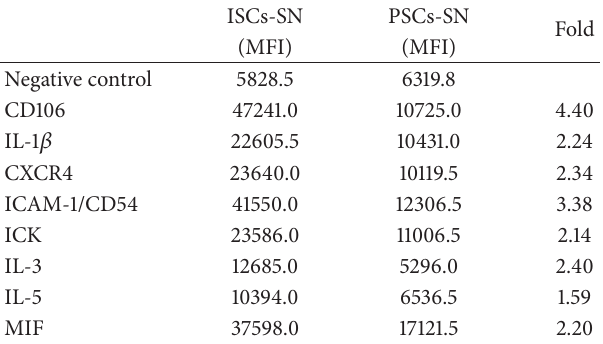
Table 3: Cytokines were highly expressed in ISCs-SN than in PSCs- SN. MFI of ISCs-SN ≥ 1.5-fold of PSCs-SN was considered as highly